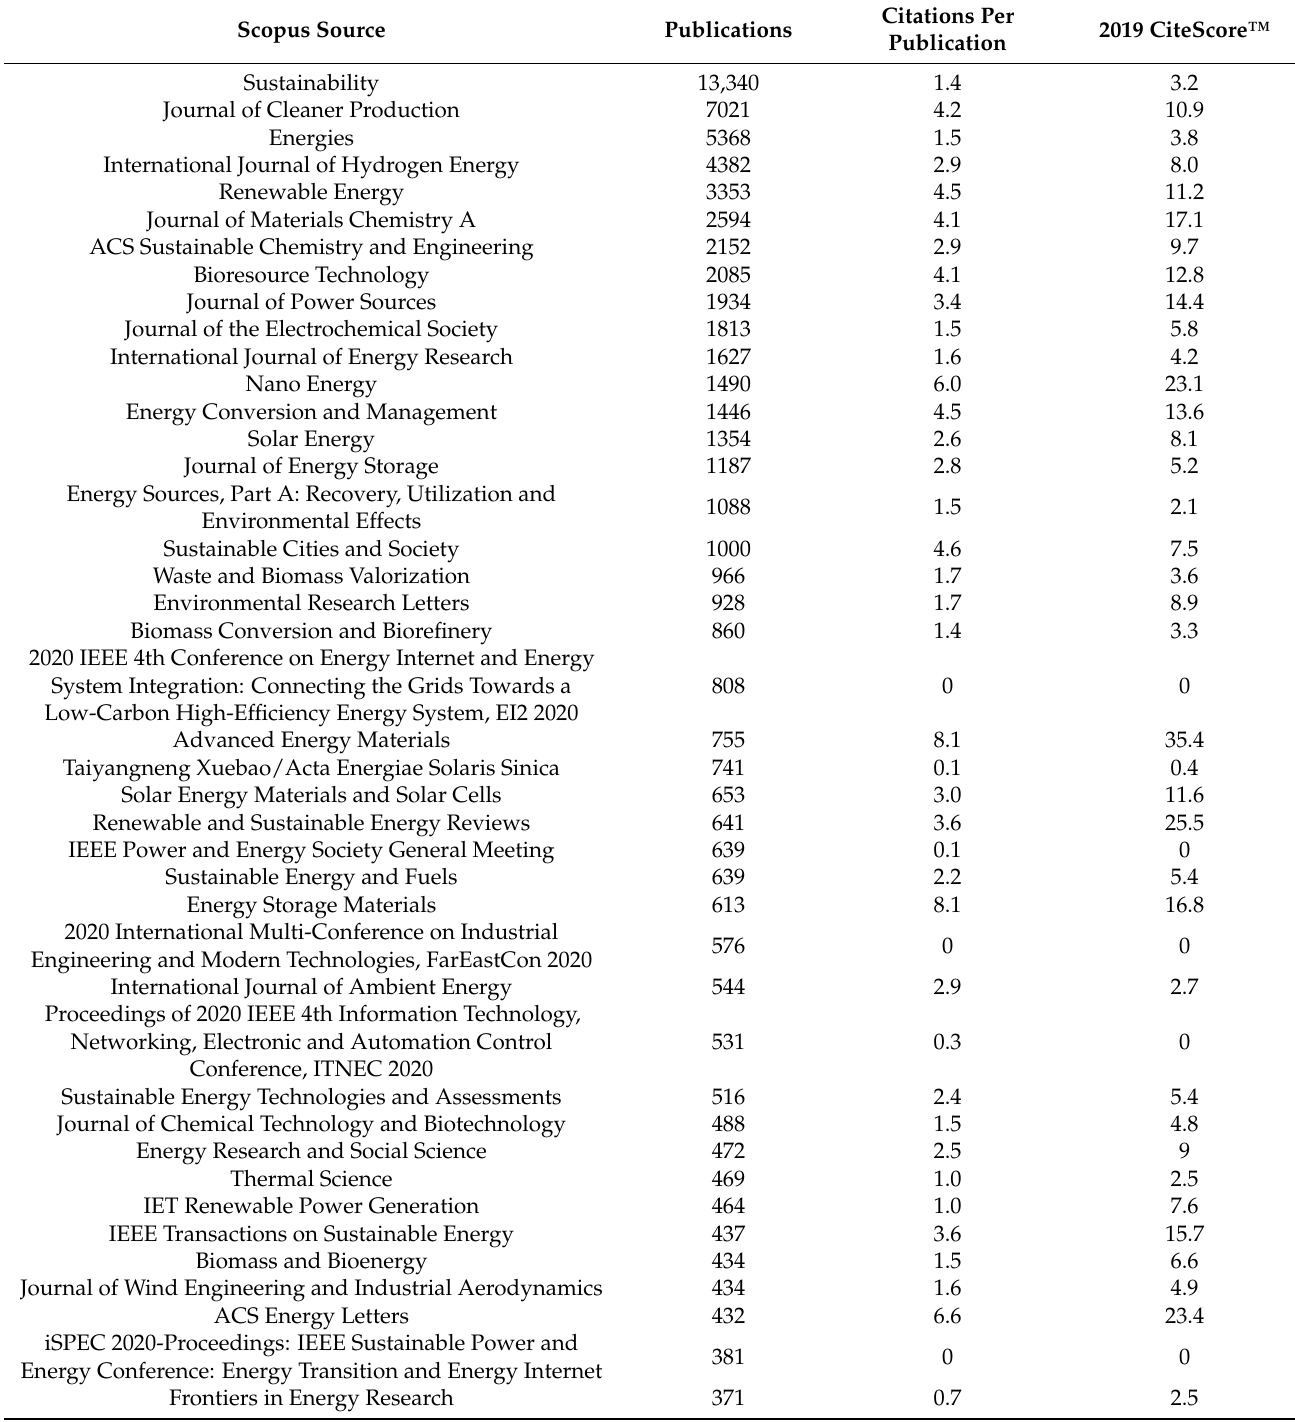
Table A1. Top 100 Scopus sources by publications on renewable energy, sustainability and the environment in 2020–2021. Scopus